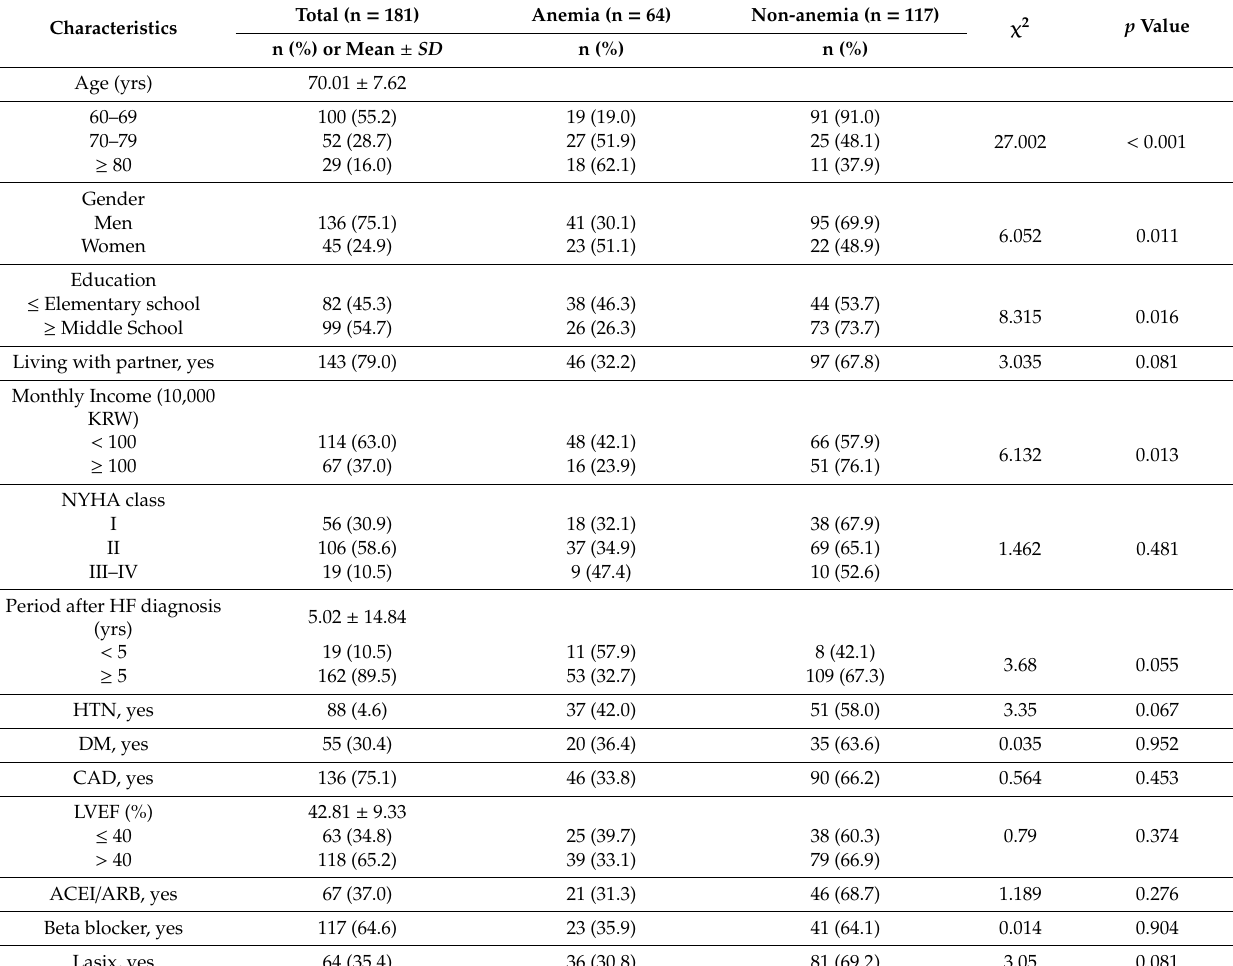
Table 1. Prevalence of anemia according to patients’ characteristics (n =